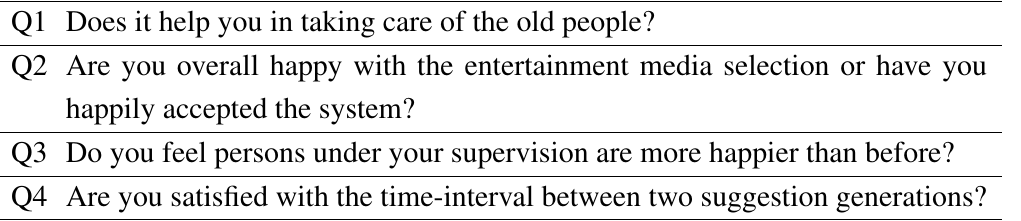
Table 8. Questions: (For